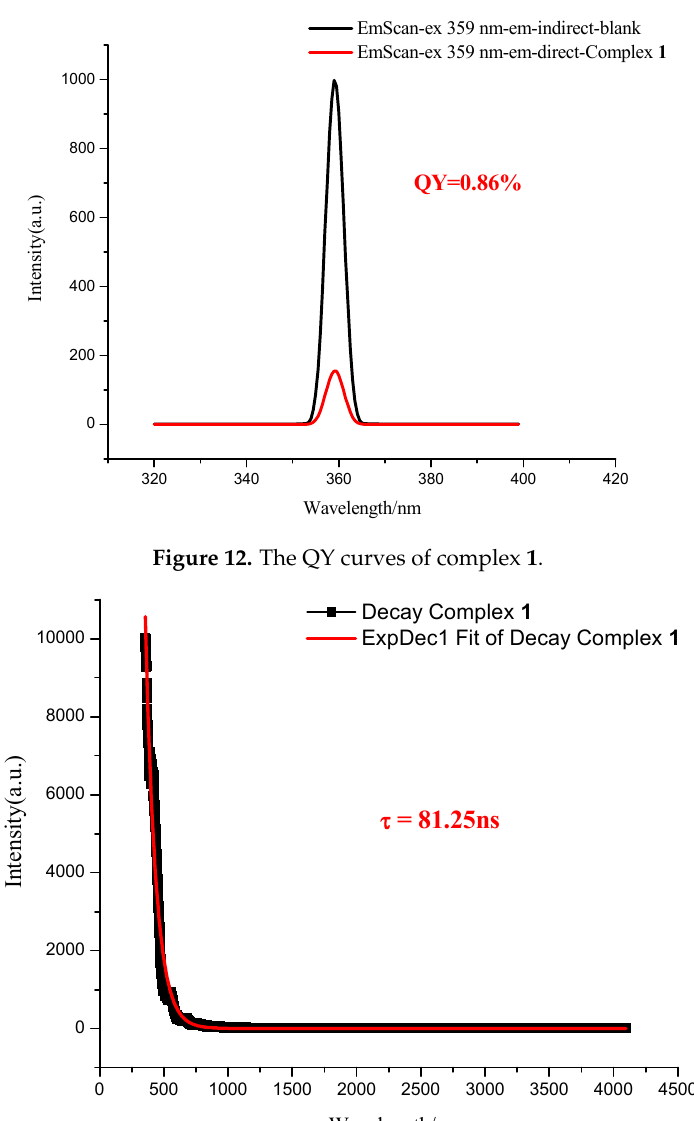
Figure 11. The photographic picture exposed at 365 nm under an ultraviolet lamp (H 2 L ligand, ( left ); complex 1 , ( right )).